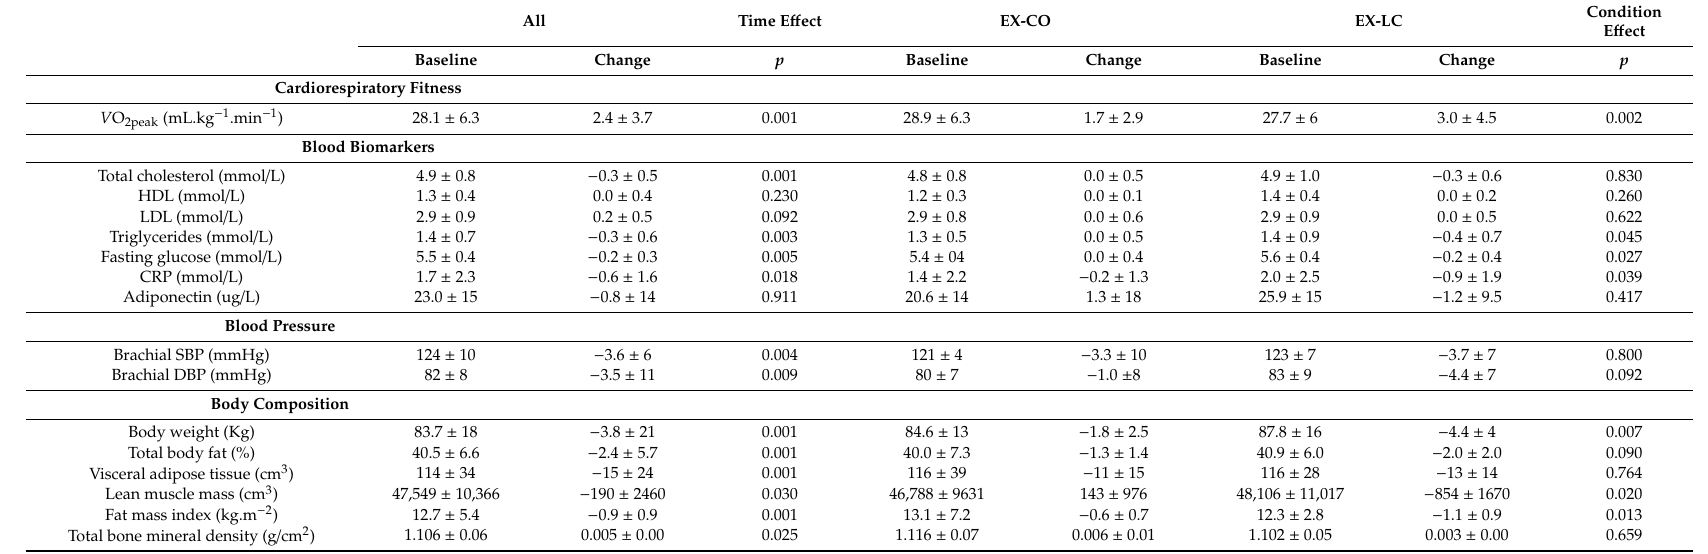
Table 2. Changes in cardiorespiratory fitness, body composition and other cardiometabolic parameters following an 8 week prescribed exercise program accompanied by standard dietary advice (EX-CO) or low-carbohydrate meals